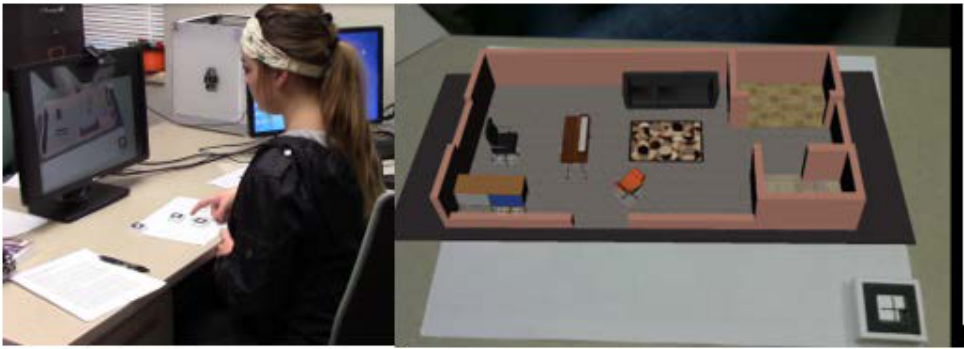
Figure 5. The augmented reality working environment.